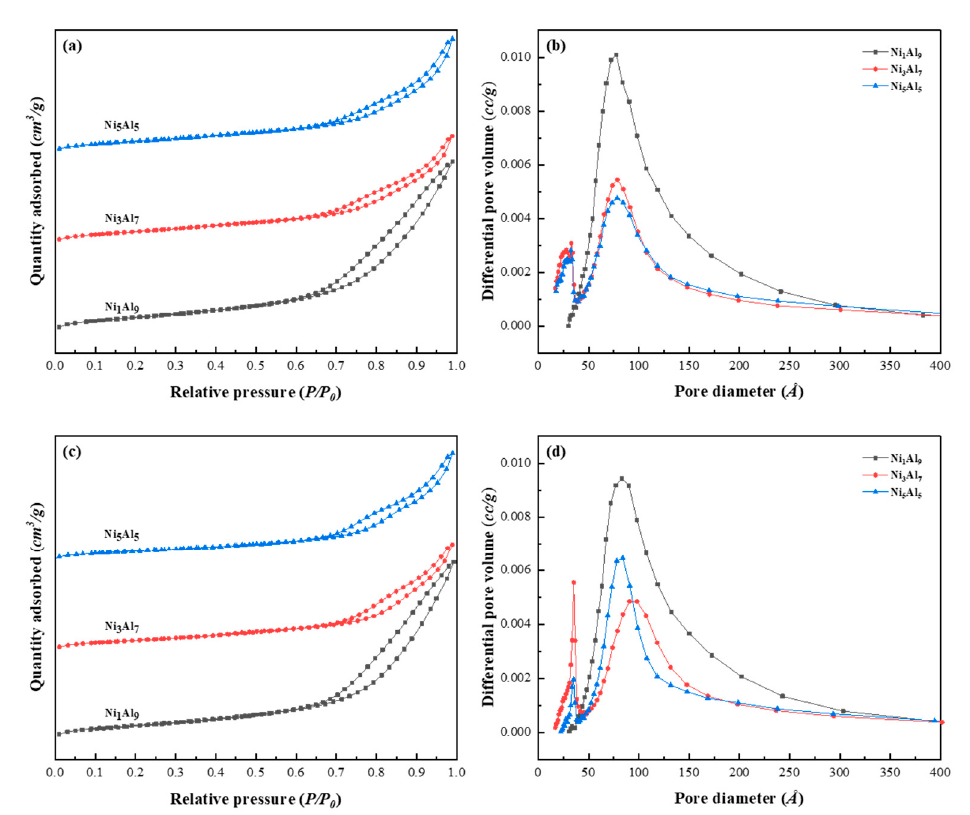
Figure 4. Pore size distribution and N 2 adsorption-desorption isotherms of the NiAl 2 O 4 catalysts with various Ni/Al ratios: ( a , c ) catalysts before reduction and ( b , d ) catalysts after reduction. Table 2. Physicochemical properties of the NiAl 2 O 4 catalysts with various Ni/Al ratios.